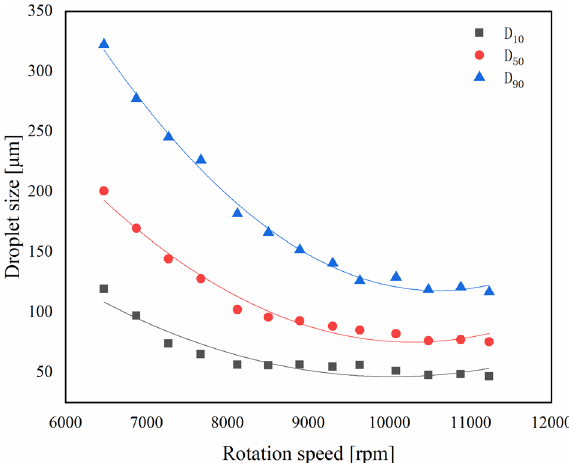
Figure 6. Relationship between the rotation speed of the centrifugal spray atomizer and droplet size. D 10 : 10% cumulative volume diameter, D